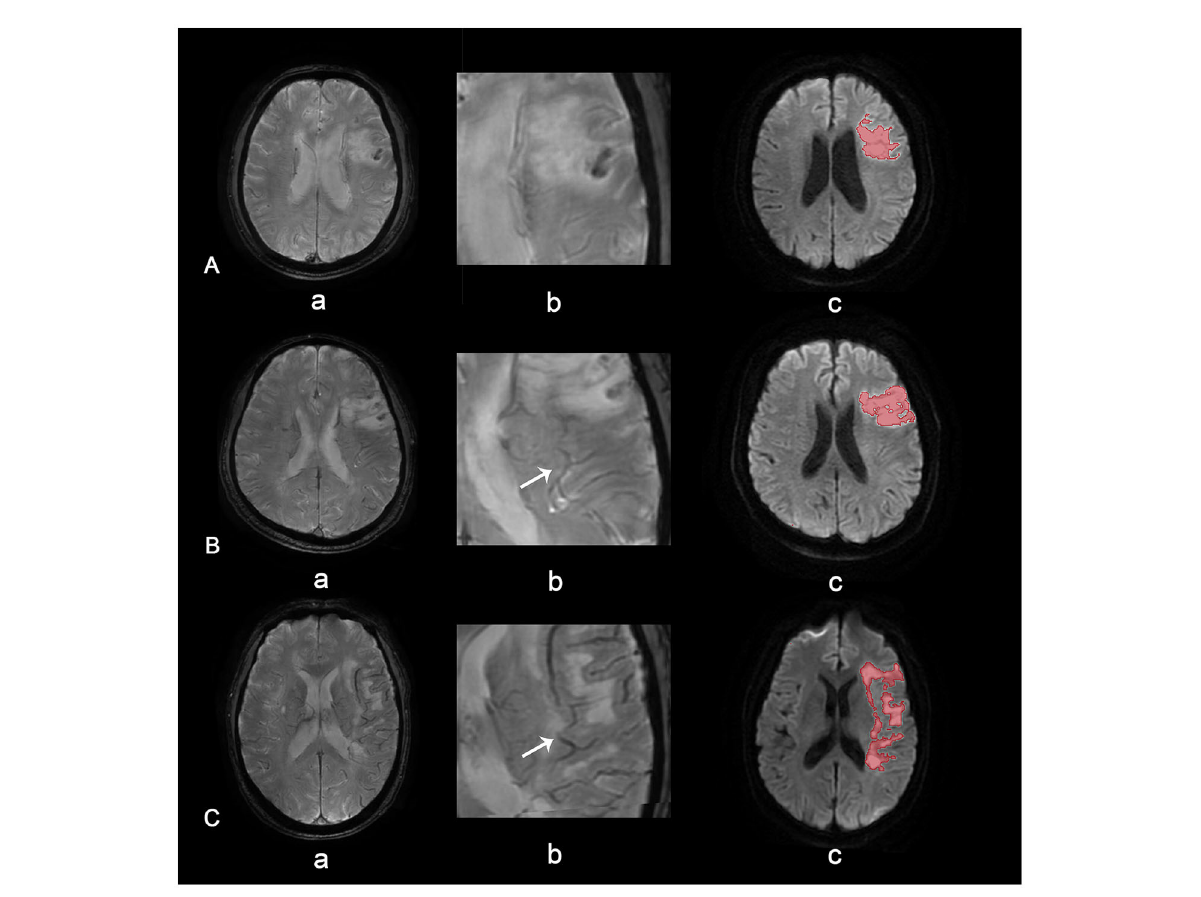
FIGURE2 APVS grades. APVS grade 0 (A) , grade 1 (B) , and grade 2 (C) . Row (a) shows SWAN images of different grades, row (b) shows magnified APVS, and row (c) shows diffusion-weighted images with quantified volume.